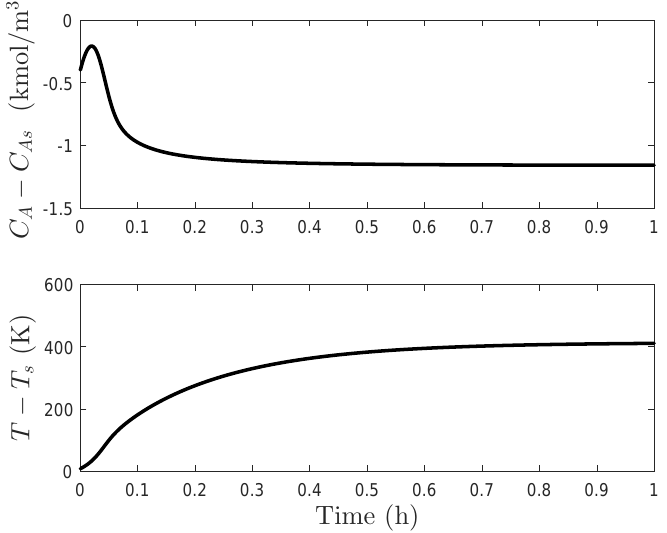
Figure 6. States over one hour of operation for the process of Equations (30) and (31) under EMPC with a sensor